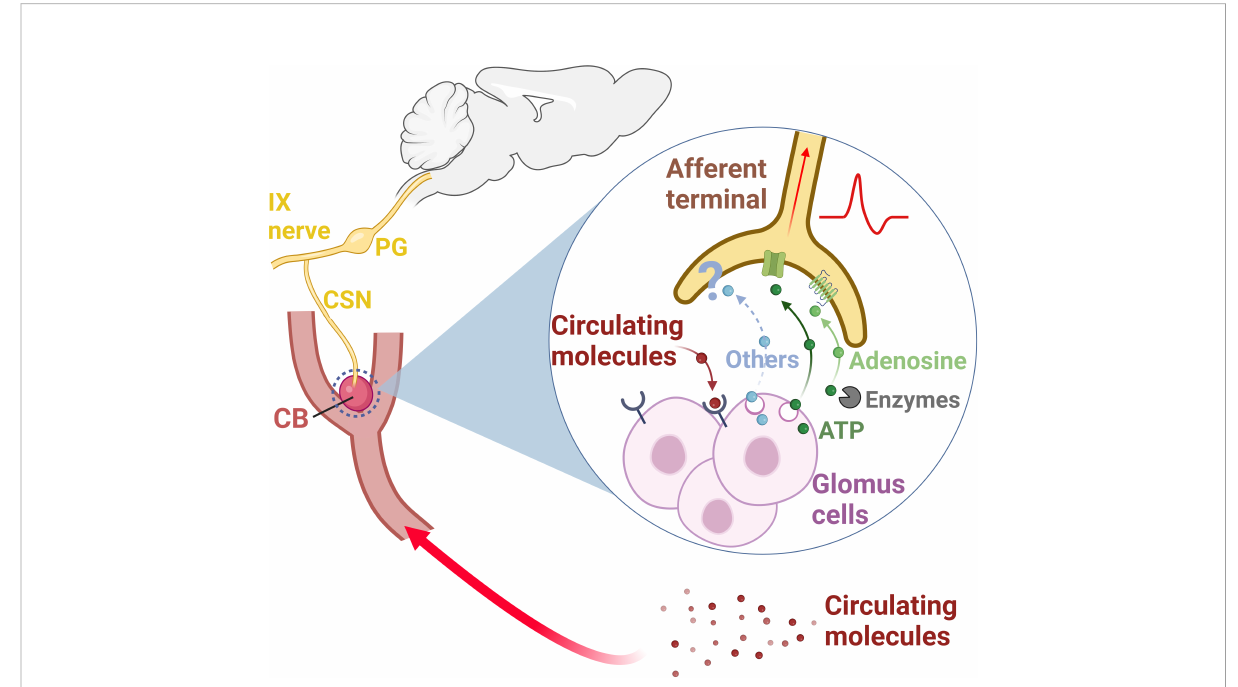
FIGURE 1 The carotid body (CB) is a sensory organ located at the carotid bifurcation (33, 34, 36). The carotid sinus nerve (CSN), a branch of the IX nerve (glossopharyngeal nerve), provides the sensory innervation to the CB (34, 36). Pseudo-unipolar neurons with cell bodies located within the petrosal ganglion (PG) convey the sensory information from the CB to the central nervous system (32, 34, 36, 37). This sensory information is multimodal, since the CB is responsive not only to changes in the partial pressure of oxygen in the arterial blood, but also to changes in the levels of several circulating molecules (epinephrine, angiotensin II, cytokines, endothelin, glucagon like peptide-1, glucose, insulin, leptin, and sodium chloride) (26, 53 – 55, 57 – 59, 61 – 64, 66, 67). Once depolarized, CB glomus cells release neurotransmitters, primarily ATP (39, 68). ATP binds to P2X2/P2X3 receptors in the afferent terminals of the CSN, generating action potentials which are propagated to the central nervous system (33, 38, 39, 68). Some of the ATP released by glomus cells is converted into adenosine by extracellular enzymes (NTPDase2,3 and ecto- 5-nucleotidase) (38). Adenosine acts on A2a receptors on CSN afferent terminals, generating action potentials, and contributing to CB signaling to the central nervous system (38 – 40). Other neurotransmitters (Others) such as acetylcholine, dopamine, and serotonin, have been also found to modulate CSN activity (33, 37, 39). CB, carotid body; CSN, carotid sinus nerve; IX nerve, glossopharyngeal nerve; PG, petrosal ganglion. Created with